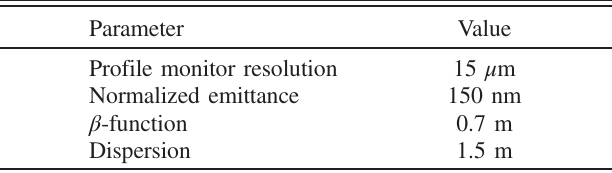
TABLE I. Simulation parameters.